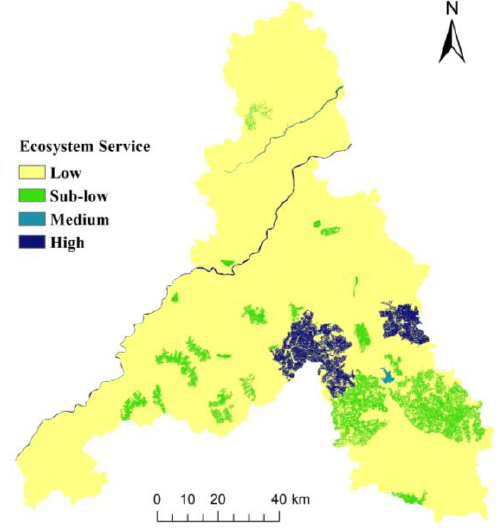
Figure 4. Ecosystem service